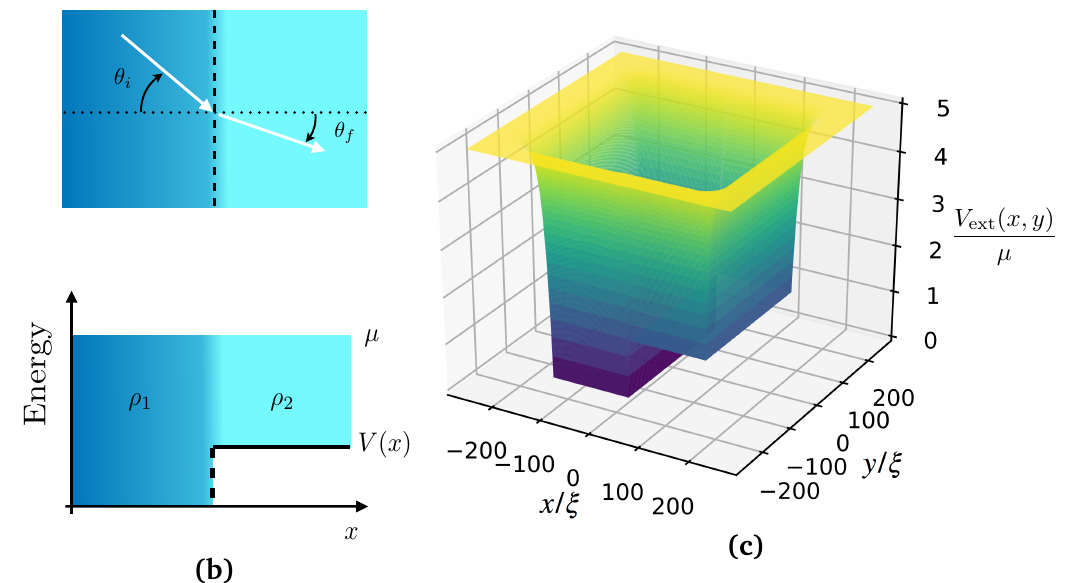
Figure 1: (a) : Schematic top-down perspective of a superfluid with a sudden change in density producing an interface. The dipoles approach the interface at incident angle θ and leave at an angle of refraction θ with respect to the normal of the i f interface. (b) : Cross-section perspective of the superfluid in figure (a) . The fluid density is reduced after a step increase in the external potential. (c) : Surface plot of the external potential V , which has dimensions 512 ξ × 512 ξ . A buffer of 100 ξ ext on each side prevents numerical noise in simulations. The potential well features an adjustable step allowing for control of the superfluid density in one half of the